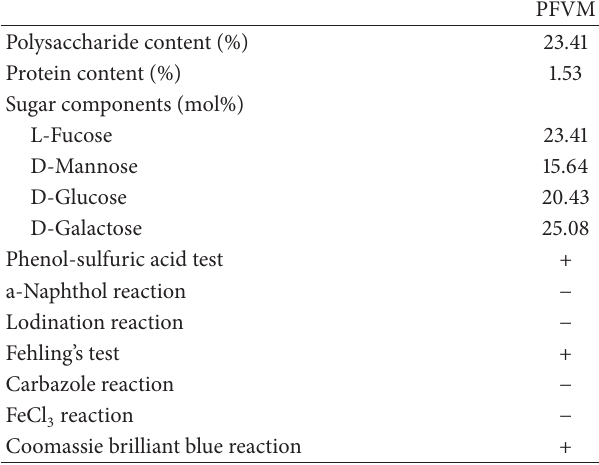
Table 1: Comparison of the yields and basic physicochemical characteristics of PFVM (+ positive, −